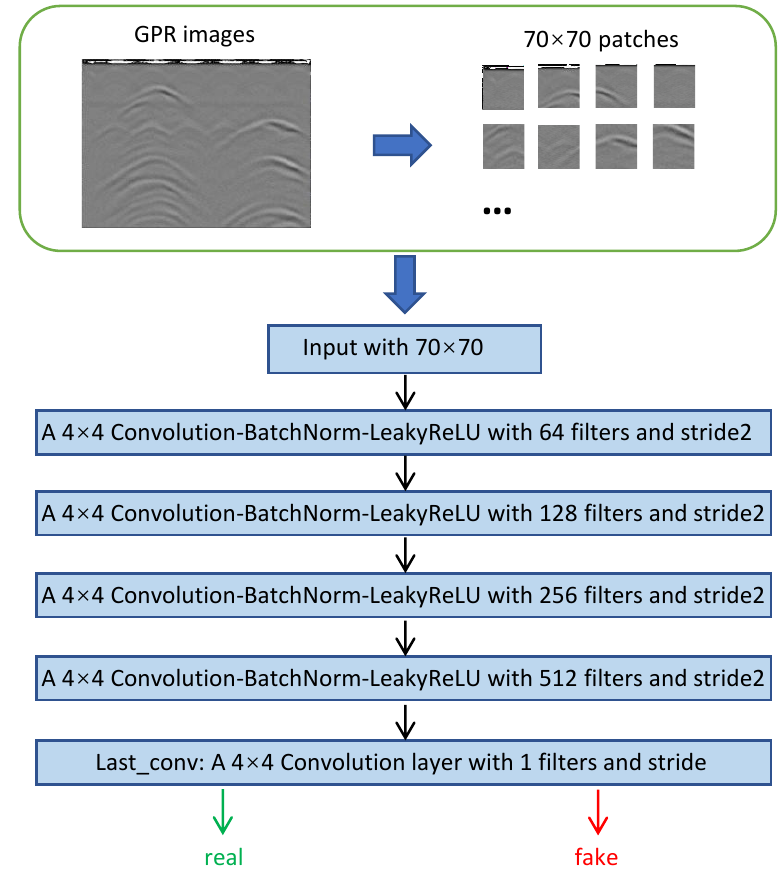
Figure 4. Architecture of the PatchGAN